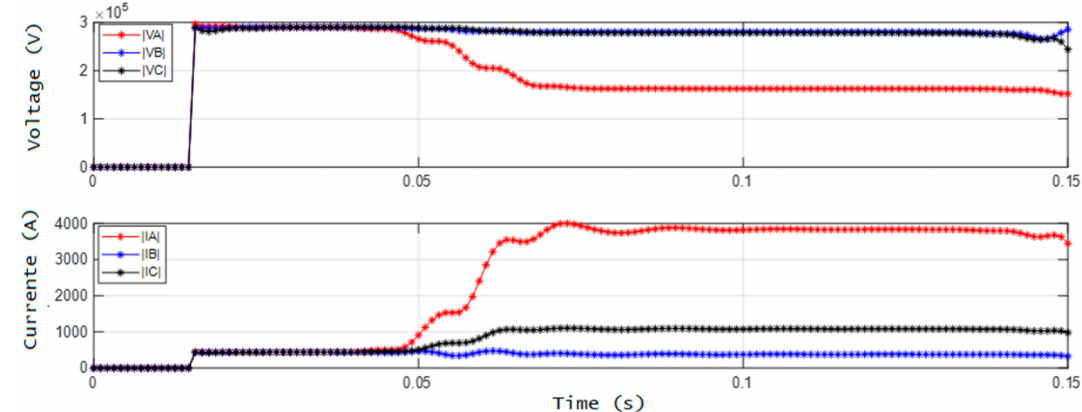
Figure 6. Filtered voltage and current waves—AG fault.